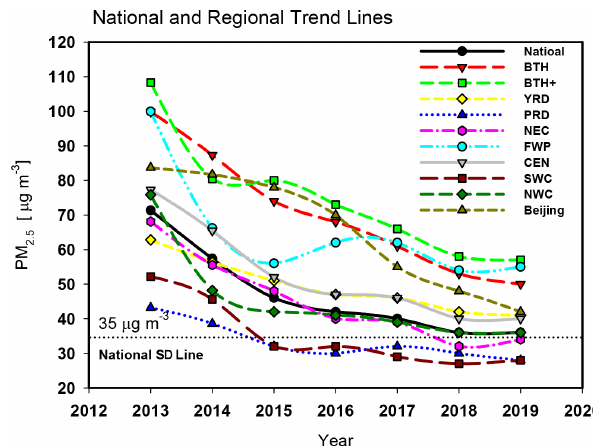
Figure 1. Analysis region separation and definition.